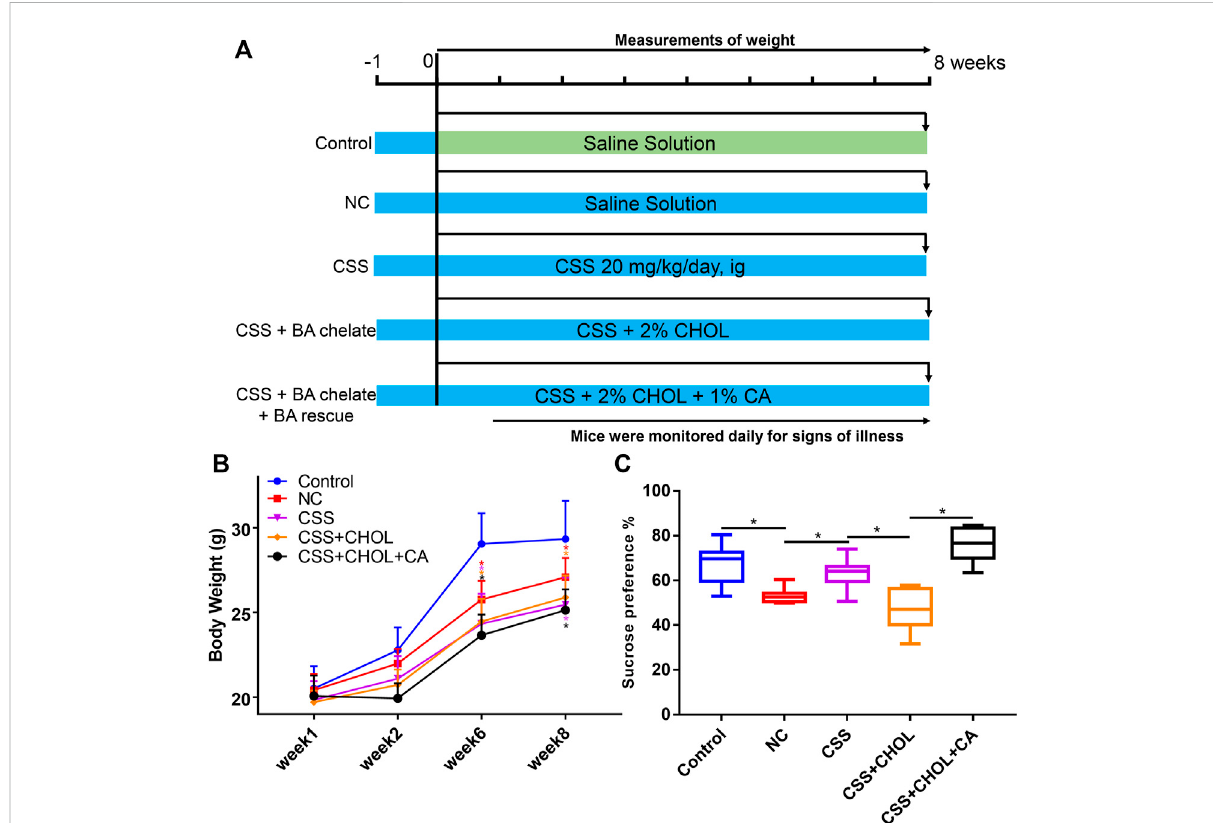
FIGURE 1 EffectofCSSandBAmanipulationonbodyweightandsucrosepreferenceinaCUMSmousemodelofdepression.MicewereexposedtoCUMS and treated with saline (NC group), CSS, or CSS along with the BA sequestrant CHOL with or without CA supplementation. Control mice were not exposed to CUMS but received saline. (A) Overview of experimental groups and timelines. (B) Body weights of mice in each group measured 1, 2, 6, and 8 weeks after starting the experiment. (C) Percent sucrose preference (based on consumption of 1% sucrose in the sucrose preference test). All values are expressed as the mean ± S.D. An asterisk “ * ” indicates p < 0.05 ( n = 8-9 mice per